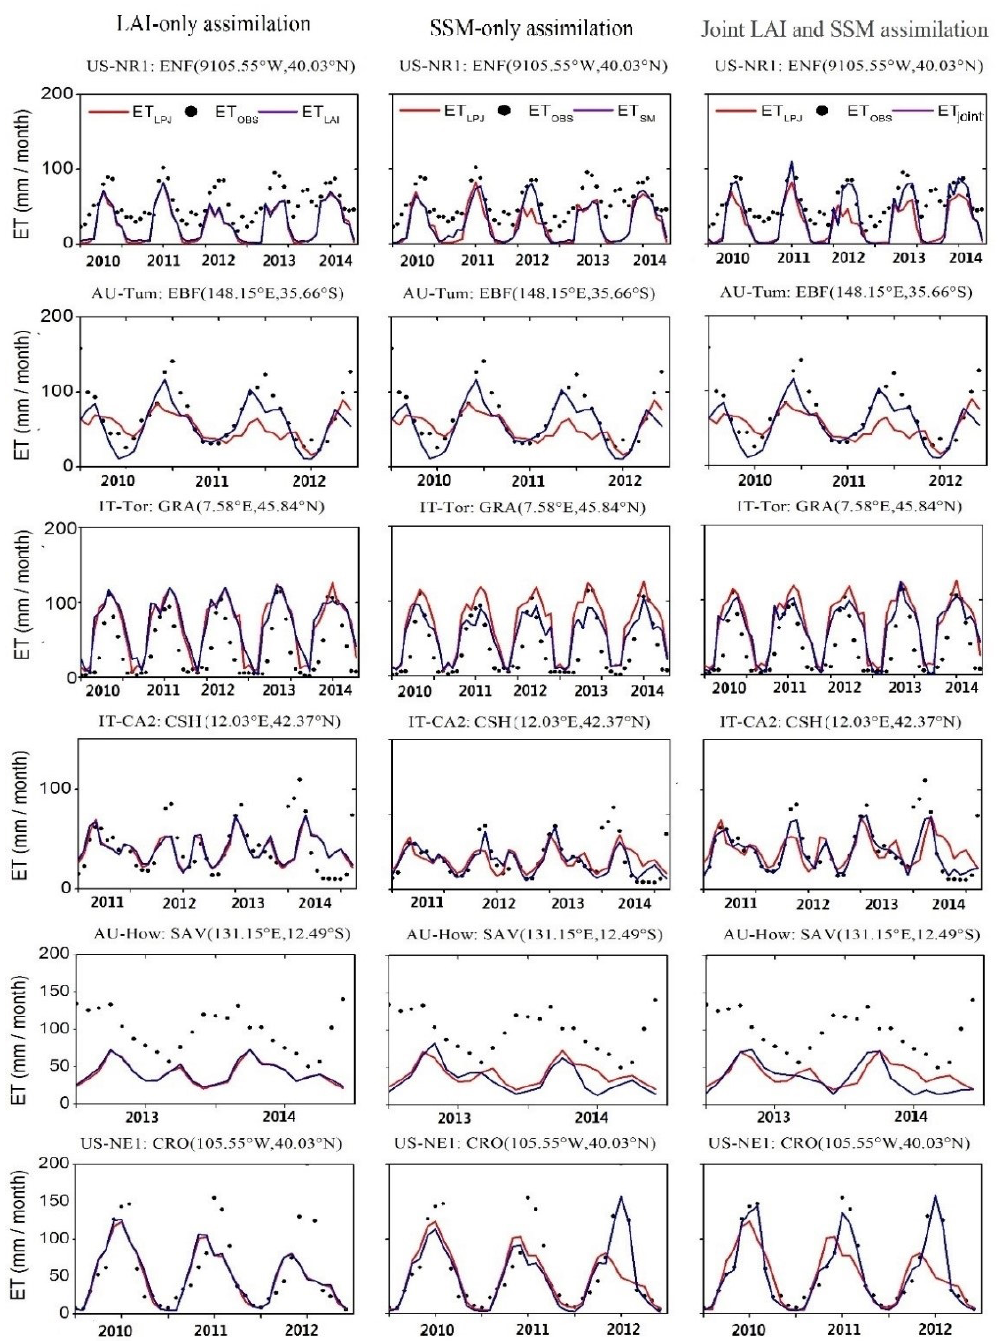
Figure 6. Seasonal cycles of tower-based and simulated ET from Lund–Potsdam–Jena (LPJ), LAI-only assimilation, SSM-only assimilation, and joint assimilation for the six sites representing six PFTs during the study